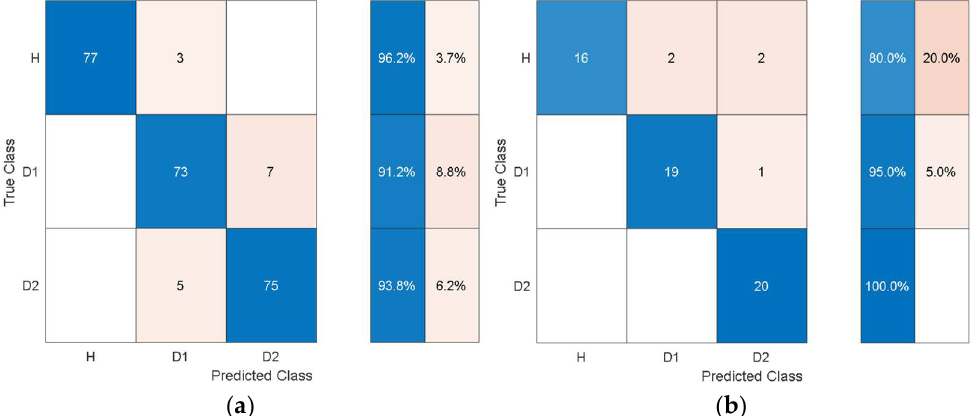
Figure 15. Classification performance of SVM using the autonomous features from the 142nd layer of GoogleNet in terms of its confusion matrices: ( a ) training; ( b ) test.